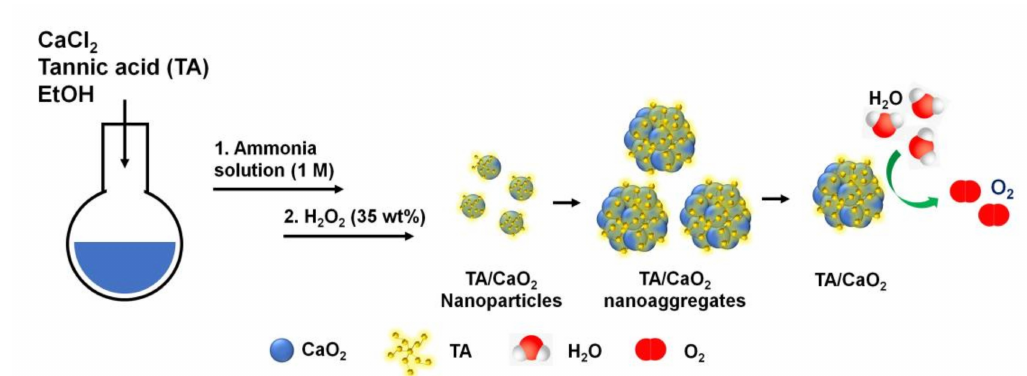
Figure 1. Schematic illustration of the synthesis of tannylated calcium peroxide (TA / CaO 2 ) nanoparticles and oxygen generation from TA / CaO 2 nanoparticles as a result of